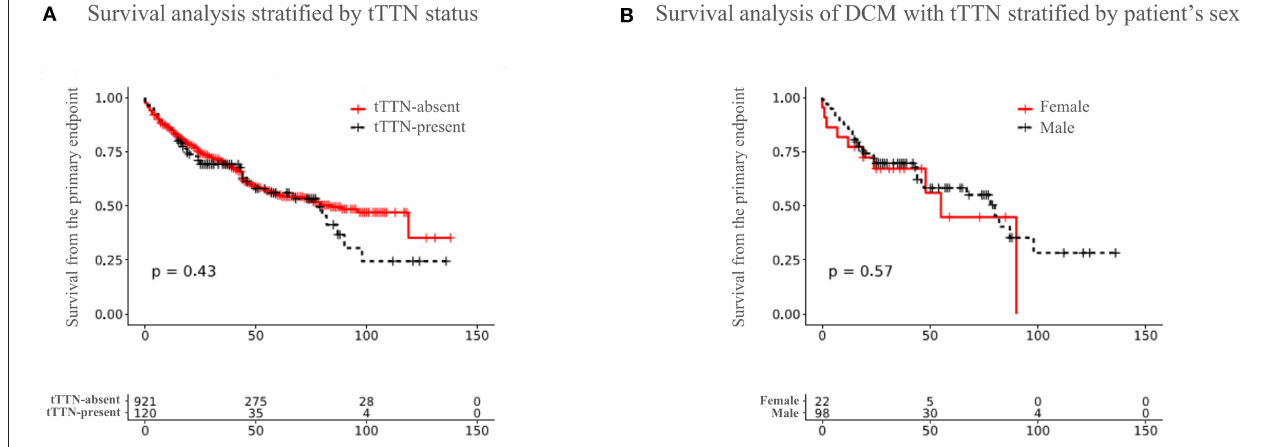
FIGURE 2 | Outcome of DCM patients in our cohort. (A) Survival curves showing freedom from the primary endpoint in the tTTN-present DCM and tTTN-absent DCM patients. Red color represents the tTTN-absent, and black color represents the tTTN-present DCM patients. (B) Survival curves comparing freedom from the primary endpoint between male and female DCM patients carrying tTTN. Red color represents female, and black color represents